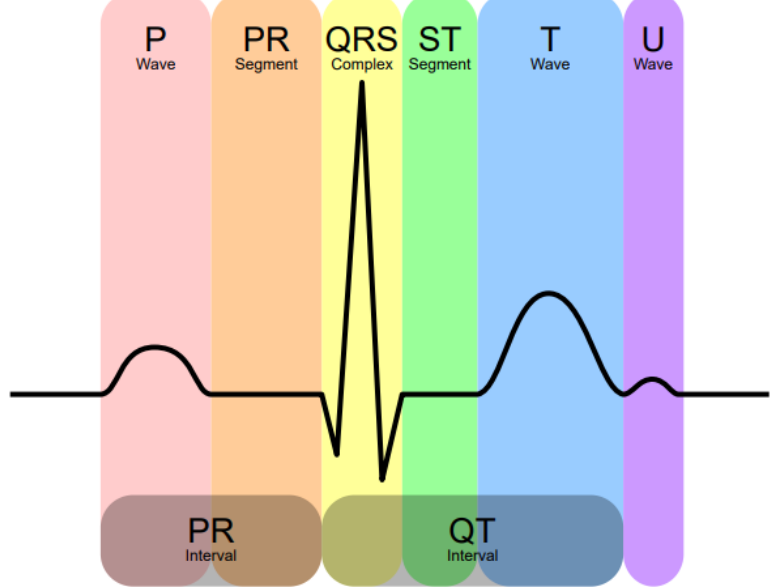
Figure 1. The main components of an electrocardiogram (author: Hank van Helvete; derivative: Rehua; source: https://commons.wikimedia.org/wiki/File:EKG_Complex_en.svg; accessed date: 1 September